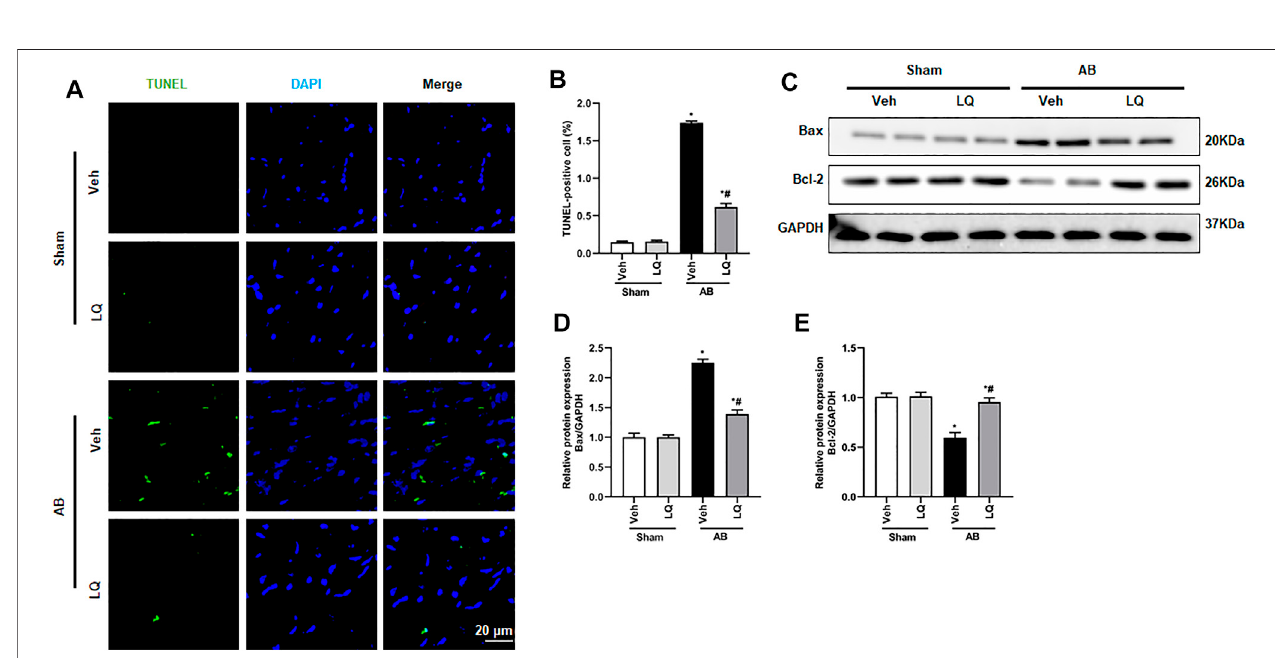
FIGURE4| Liquiritinreducescardiomyocyteapoptosis invivo . (A) RepresentativeimagesofTUNELstainingtoexaminemyocardialapoptosis. (B) Quanti fi cationof TUNEL-positivecells( n =6). (C) RepresentativeimmunoblotsforBaxandBcl-2. (D,E) Densitometric analysisofBaxandBcl-2 expression. Bax2and Bcl-2signalswere normalizedtothoseofGAPDH.Dataarepresentedasthemean±SEM.One-wayANOVAwasperformedtoexaminestatisticaldifferencesamongdifferentgroups.* p < 0.05 vs. Sham + Veh. # p < 0.05 vs. AB + Veh.